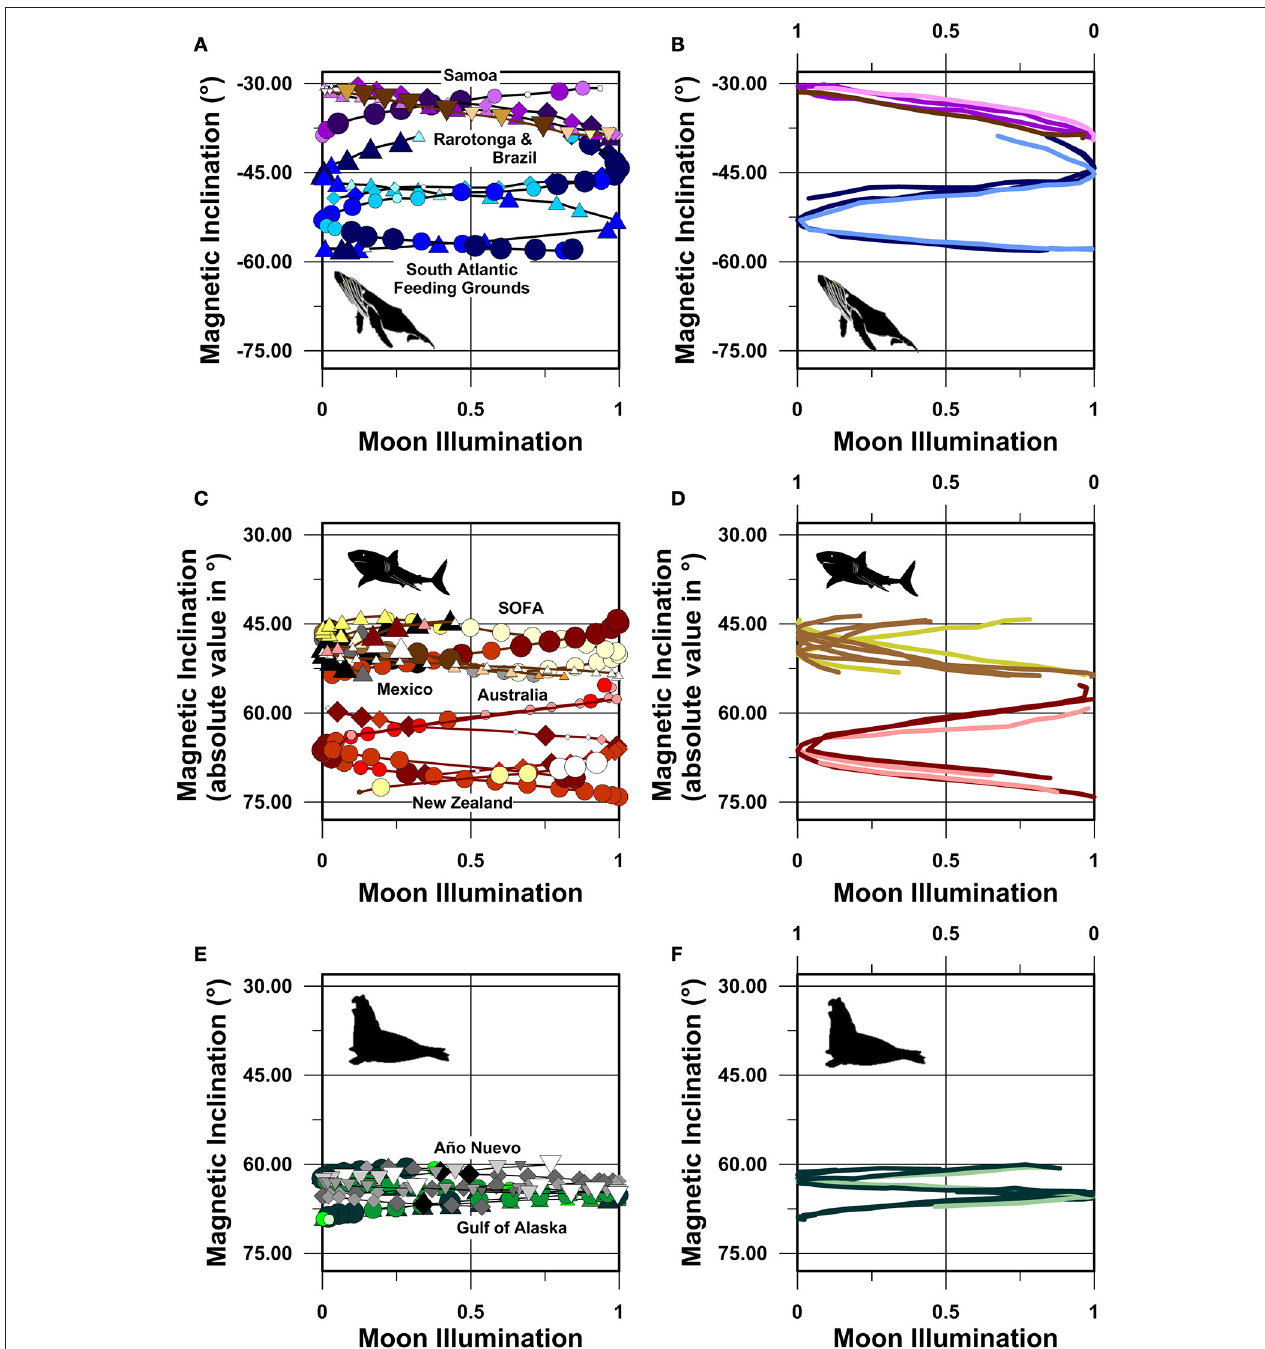
FIGURE 5 | Magnetic inclination vs. moon illumination plots. (A,B) Humpback whales in the South Atlantic and South Pacific Oceans, (C,D) great white sharks in the South Pacific and North Pacific Oceans, (E,F) northern elephant seals in the North Pacific Ocean. Symbols as in Figures 1 – 3 . In (B,D,F) , average daily location symbols have been removed, and the tracks of PTT numbers 87769.08, 120946.14, 55614.15, 55615.15, 19787.10, 19787.11, and 39455.05 are plotted against the upper reverse moon illumination axis. These seven tracks are thus mirrored across the 0.5 (i.e., 50%) moon illumination value. (B,D,F) are included in order to show the symmetrical in-phase or antiphase distribution of the data with respect to the synodic cycle. These 7 mirror-image tracks are plotted as lighter colored lines. All other tracks ( n = 15) are plotted against the lower moon illumination axis and are shown as darker colored lines. Magnetic inclination values in (C,D) are plotted as absolute values due to the fact that the two white shark populations reside in opposite magnetic hemispheres. Magnetic inclination axis values span the same range in all panels to facilitate comparisons between the three species.